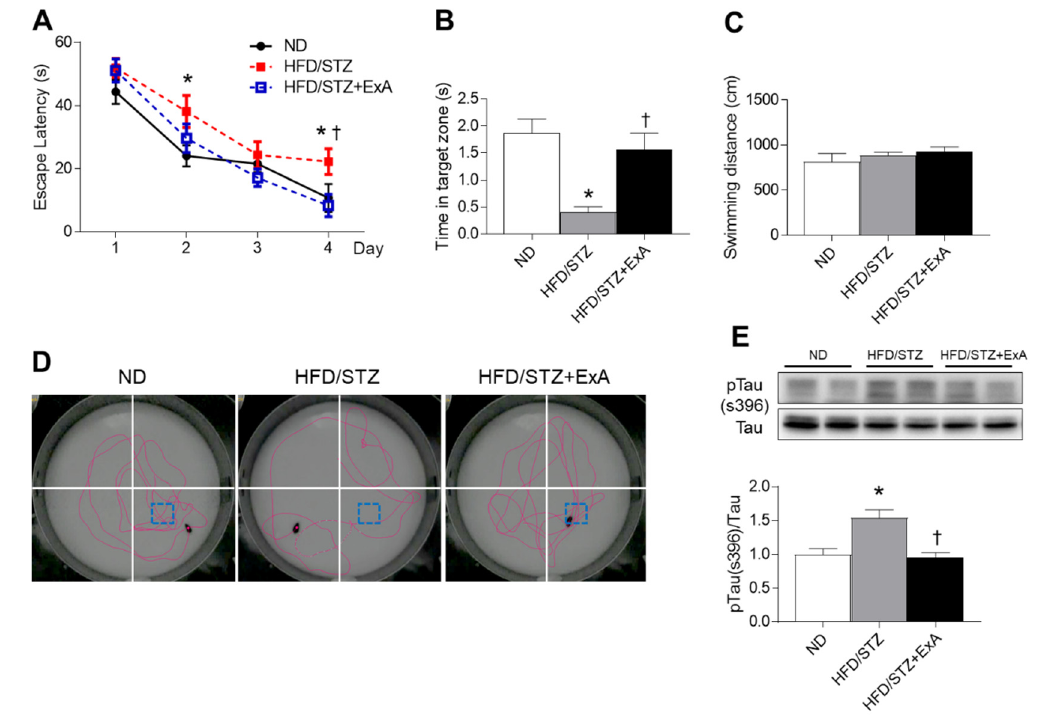
Figure 5. Effects of long-acting exendin-4-ABD-anti-FcRn affibody (ExA) on memory deficits and hippocampal tau phosphorylation levels in HFD/STZ mice. ( A ) Escape latency over 4 days during Morris water maze training in ND-fed mice, HFD/STZ mice, and ExA-treated HFD/STZ mice (HFD/STZ+ExA). ( B ) Average time spent in the target zone, ( C ) swimming distance, and ( D ) representative swimming paths during the probe trial. ( E ) Western blot and quantitative analysis results showing phosphorylated tau (S396) and total tau expression in the hippocampus ( n = 3–4 mice per group). Data are shown as the mean ± SEM. *: p < 0.05 vs. ND-fed mice, †: p < 0.05 vs. HFD/STZ mice.